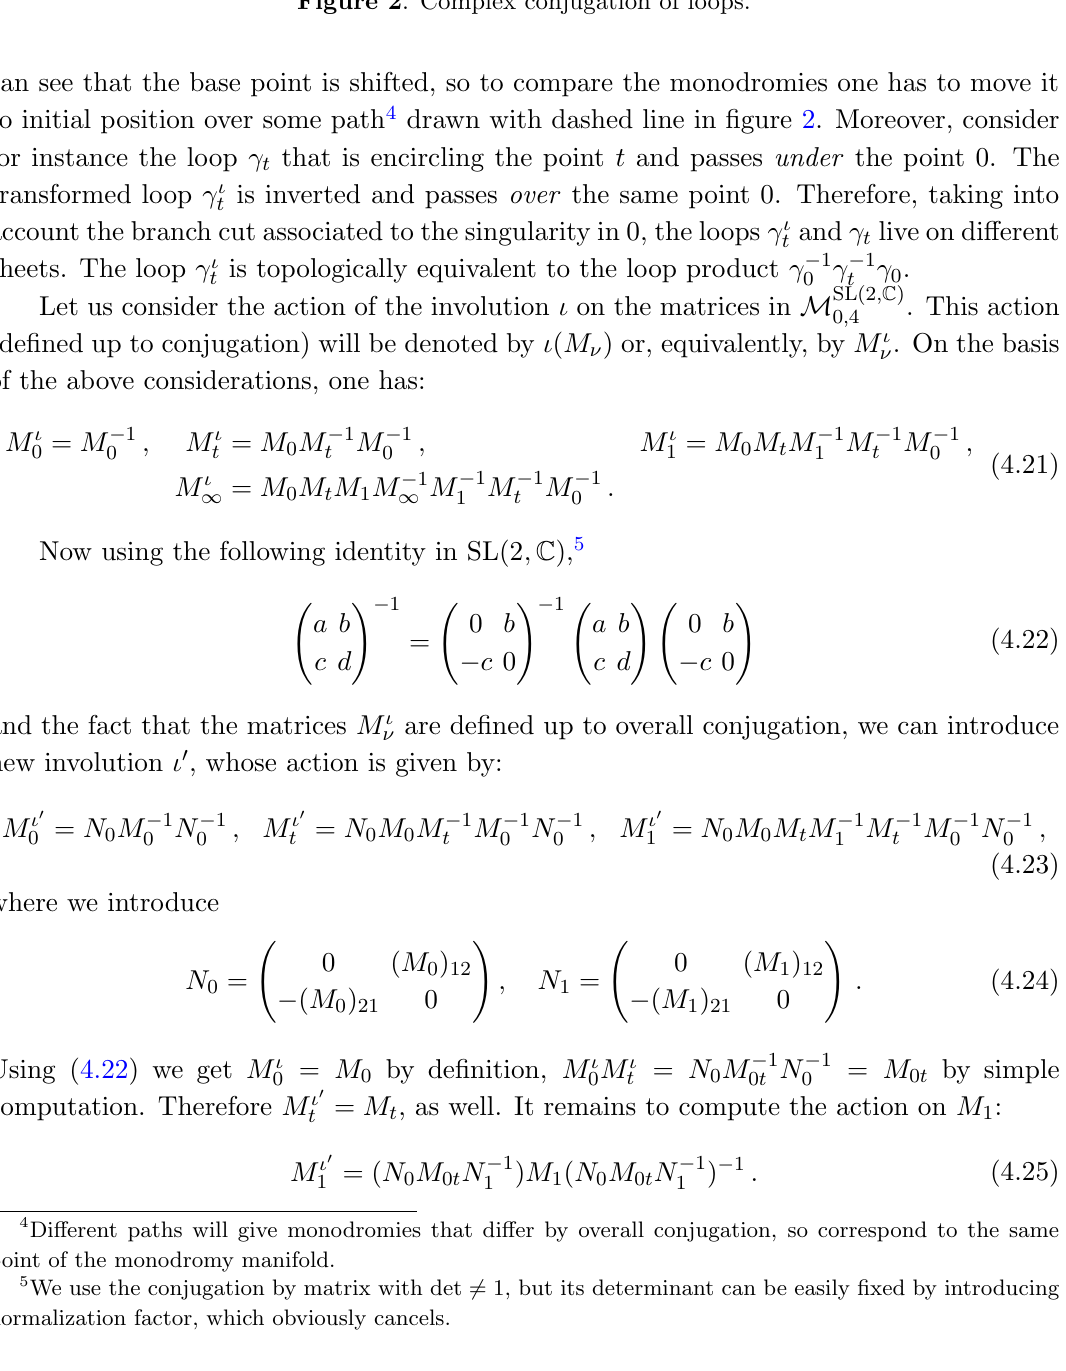
Figure 2 . Complex conjugation of